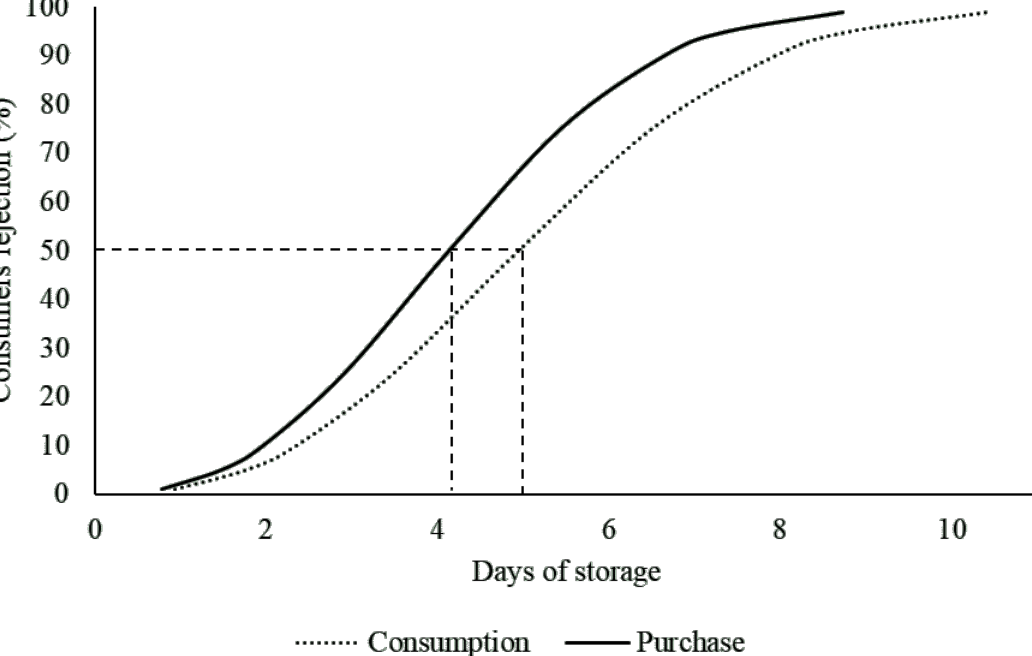
Figure 1. Probability of consumers’ rejection for the consumption and purchase of Nile tilapia ( Oreochromis niloticus ) fillets versus storage time at 4 ± 1 °C by Weibull distribution; 50% rejection points are indicated by the dashed line.